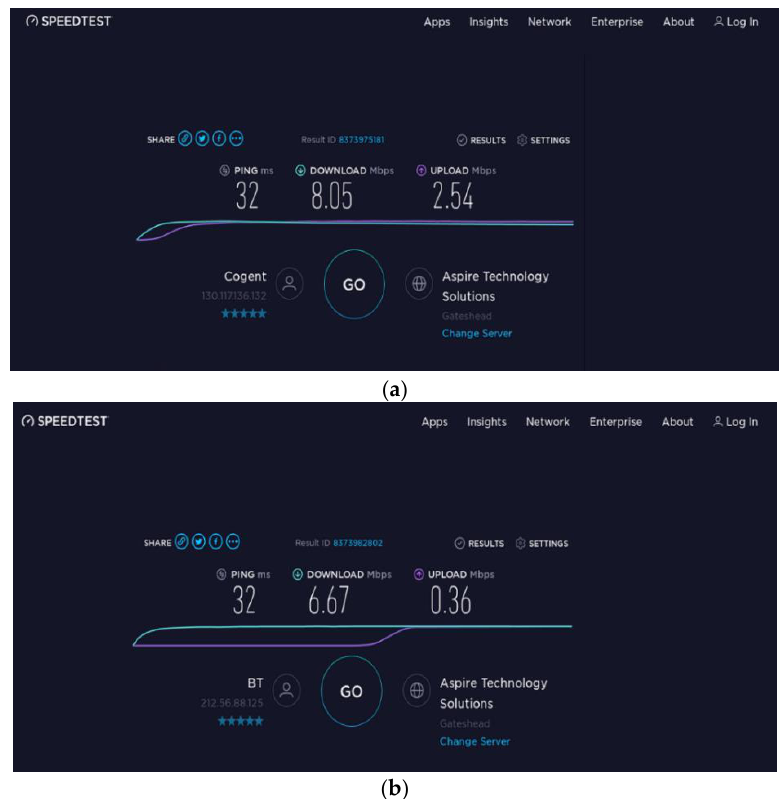
Figure 17. Internet speed test measurements ( a ) through the optical link and ( b ) through landline broadband.